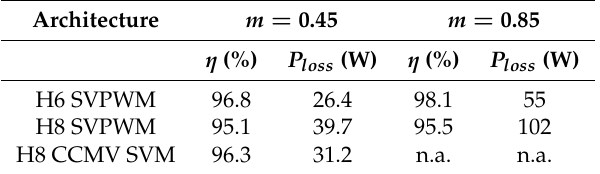
Table 5. Comparison between H6 SVPWM, H8 SVPWM and H8 CCMV SVM with Silicon IGBT.